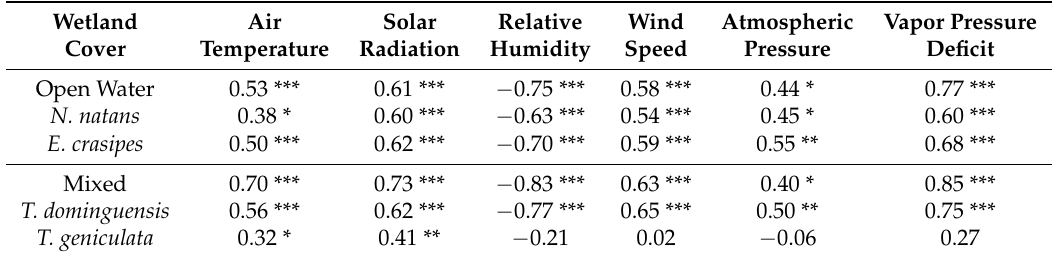
Table 2. Person correlation analysis among the evaporation from wetland covers and meteorological variables during the study at Palo Verde National Park, Costa Rica. Significant correlations among evaporation and meteorological variables were tested with the following significance levels: p =0.05(*), p =0.01(**) and p =0.001(***). Wetland Air Solar Relative Wind Atmospheric Vapor Pressure Cover Temperature Radiation Humidity Speed Pressure Deficit Open Water 0.53 *** 0.61 *** − 0.75 *** 0.58 *** 0.44